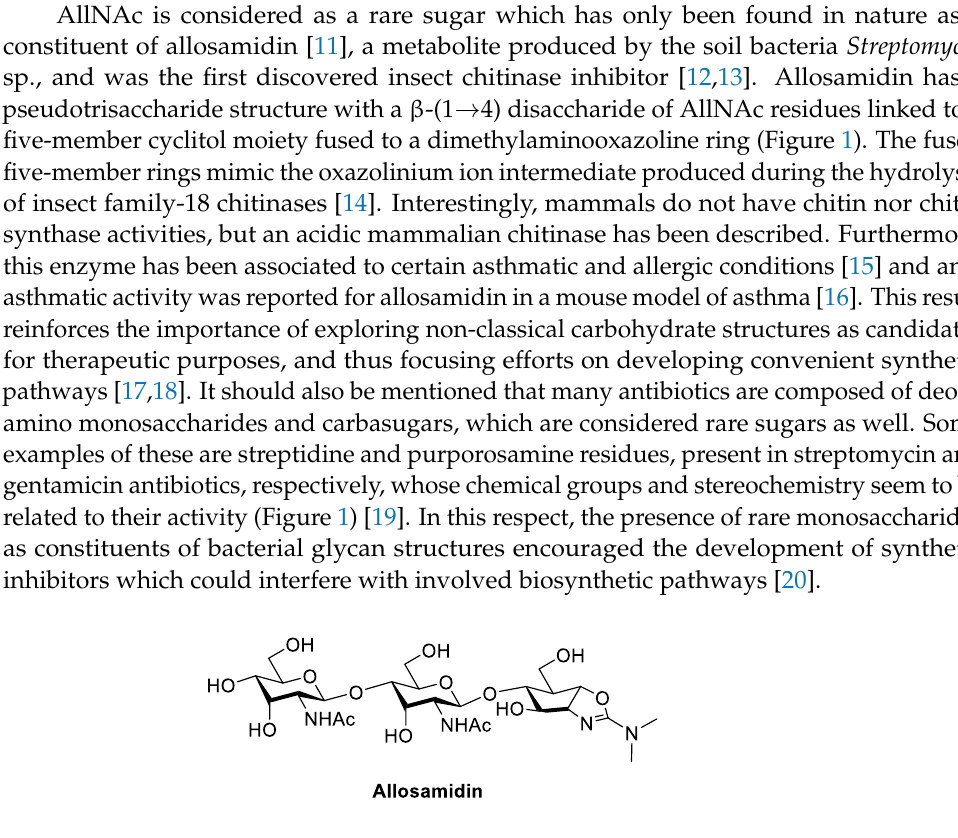
with proteins such as CD44 [27]. Additionally, HA turnover and the related HA-derived oligosaccharides have also been investigated in this respect